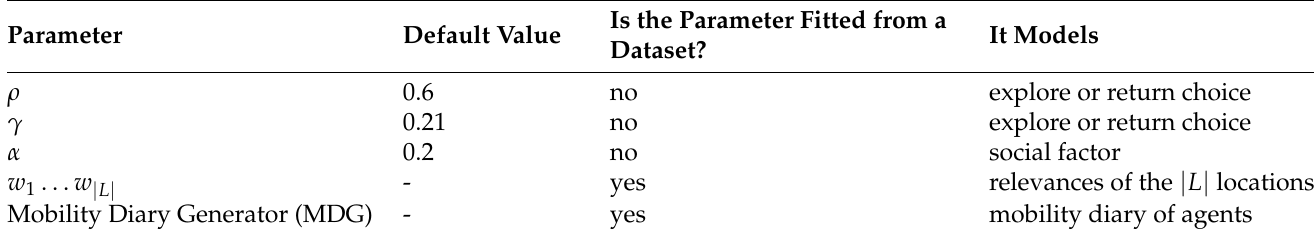
Table 1. A summary of the parameters of